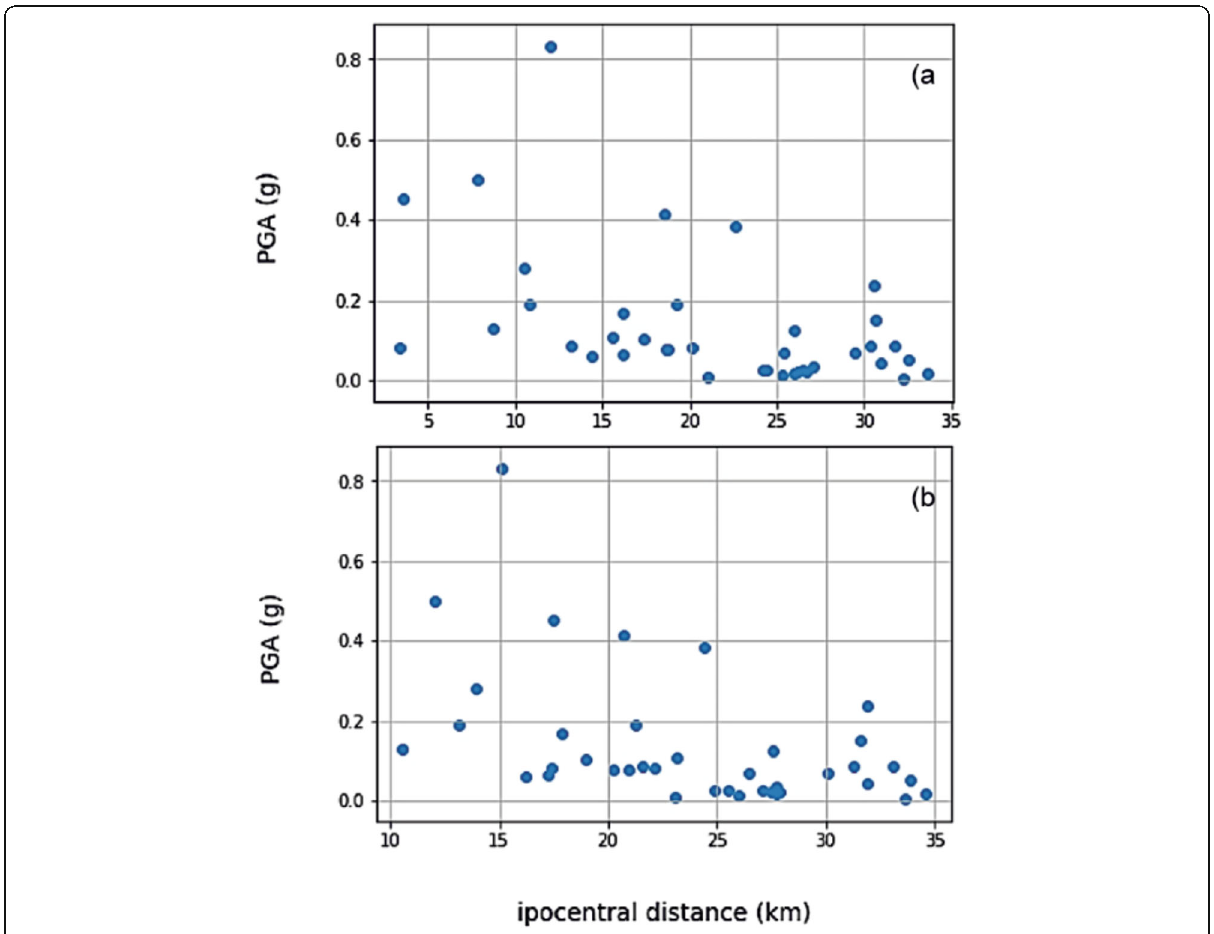
Fig. 6 Datasets of PGA values recorded at NFAs in the Central Italy Apennine Sector from 1997 to 2017 divided into two ranges of M w : a 5 ≤ M w1 < 5.5; b 5.5 ≤ M w2 ≤